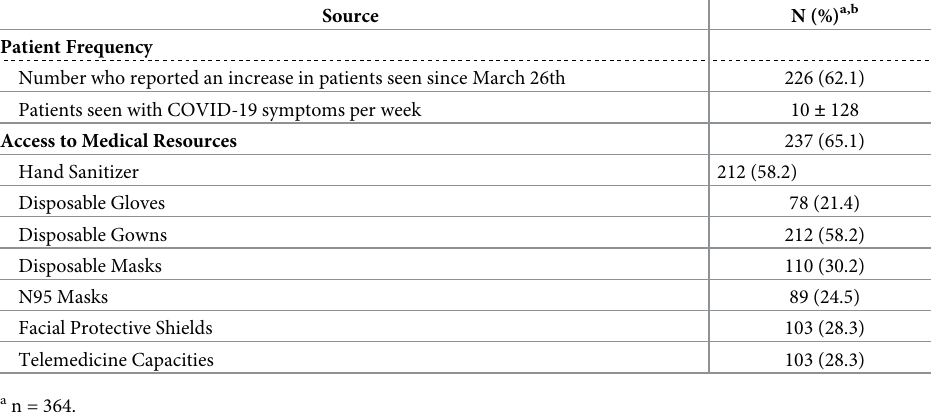
Table 4. Patient frequency and access to medical resources among Somali healthcare workers.